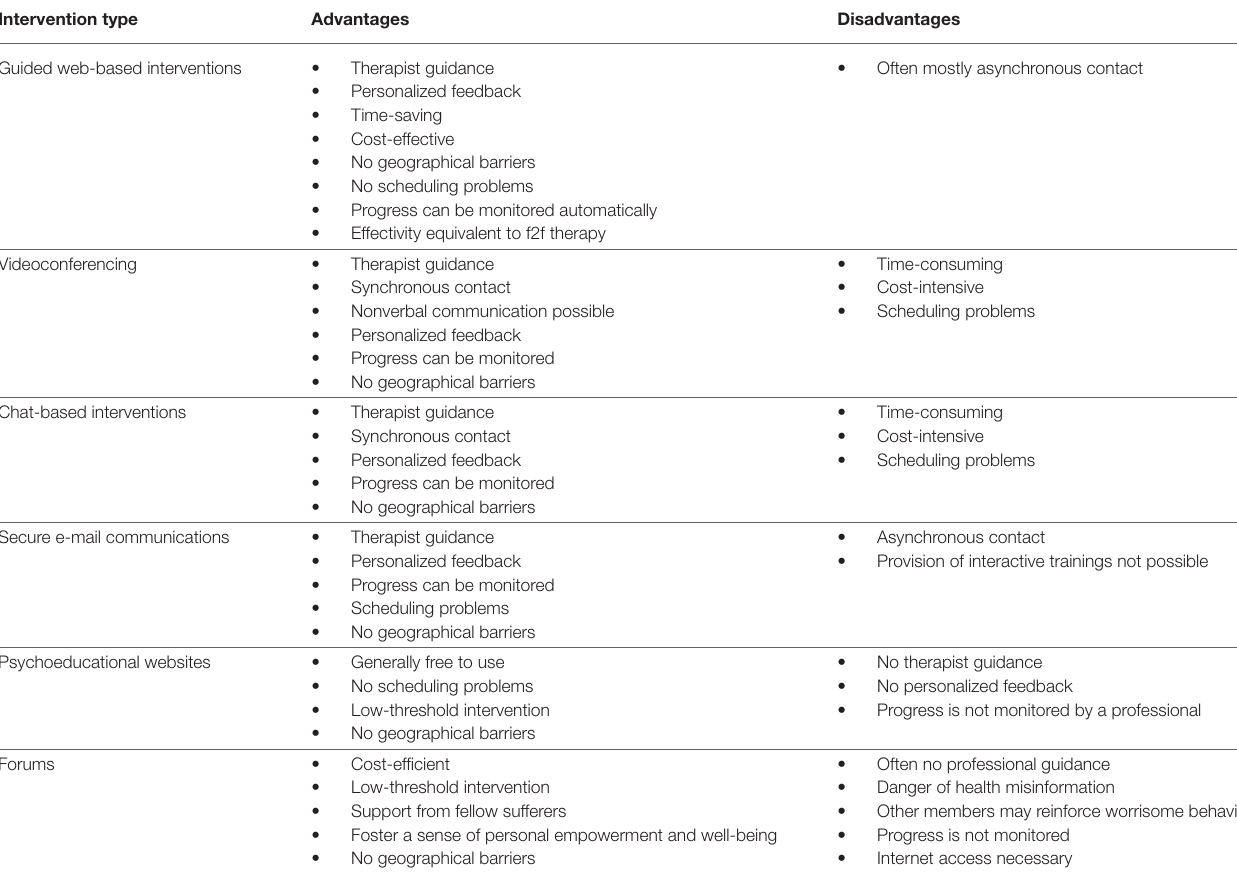
TABLE 1 | Advantages and disadvantages of different types of web-based interventions adapted from